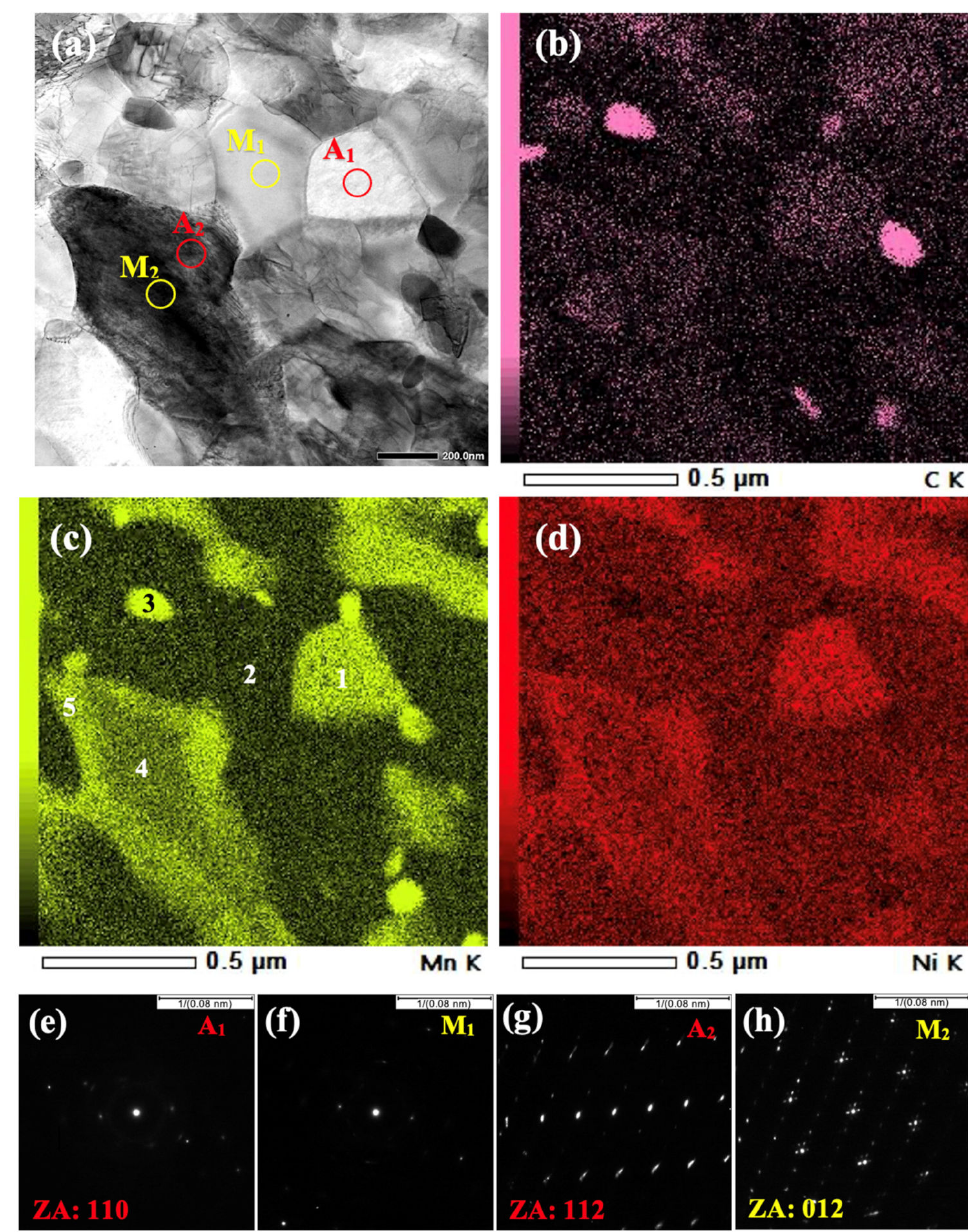
Figure 9. ( a ) STEM image of the Def-A650 specimen and corresponding STEM-EDS maps of ( b ) C, ( c ) Mn and ( d ) Ni distribution along with the electron diffraction patterns taken from the areas ( e ) A 1 , ( f ) M 1 , ( g ) A 2 and ( h ) M 2